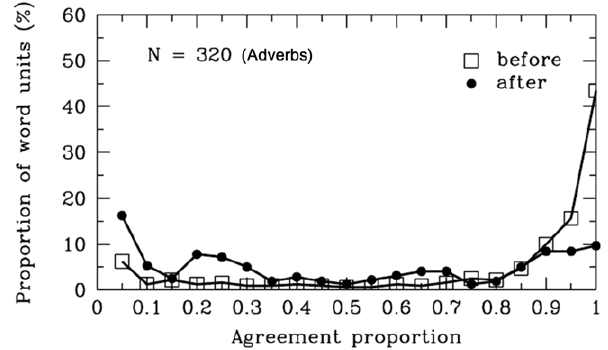
Figure 6. Conjunctions. Frequency distribution of agreement proportions for word boundaries before (open squares) and after (filled circles) the conjunctions. The y-axis represents the proportion of SWU. The number of SWU is also represented in the